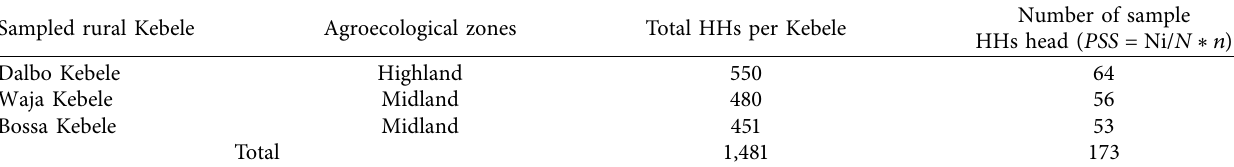
Table 1: Household sample distribution in sampled Kebeles of each stratum. Sampled rural